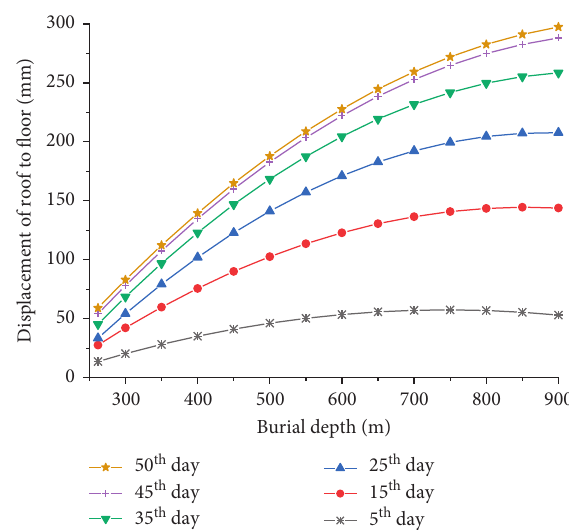
Figure 8: Comparison of displacement of roof to